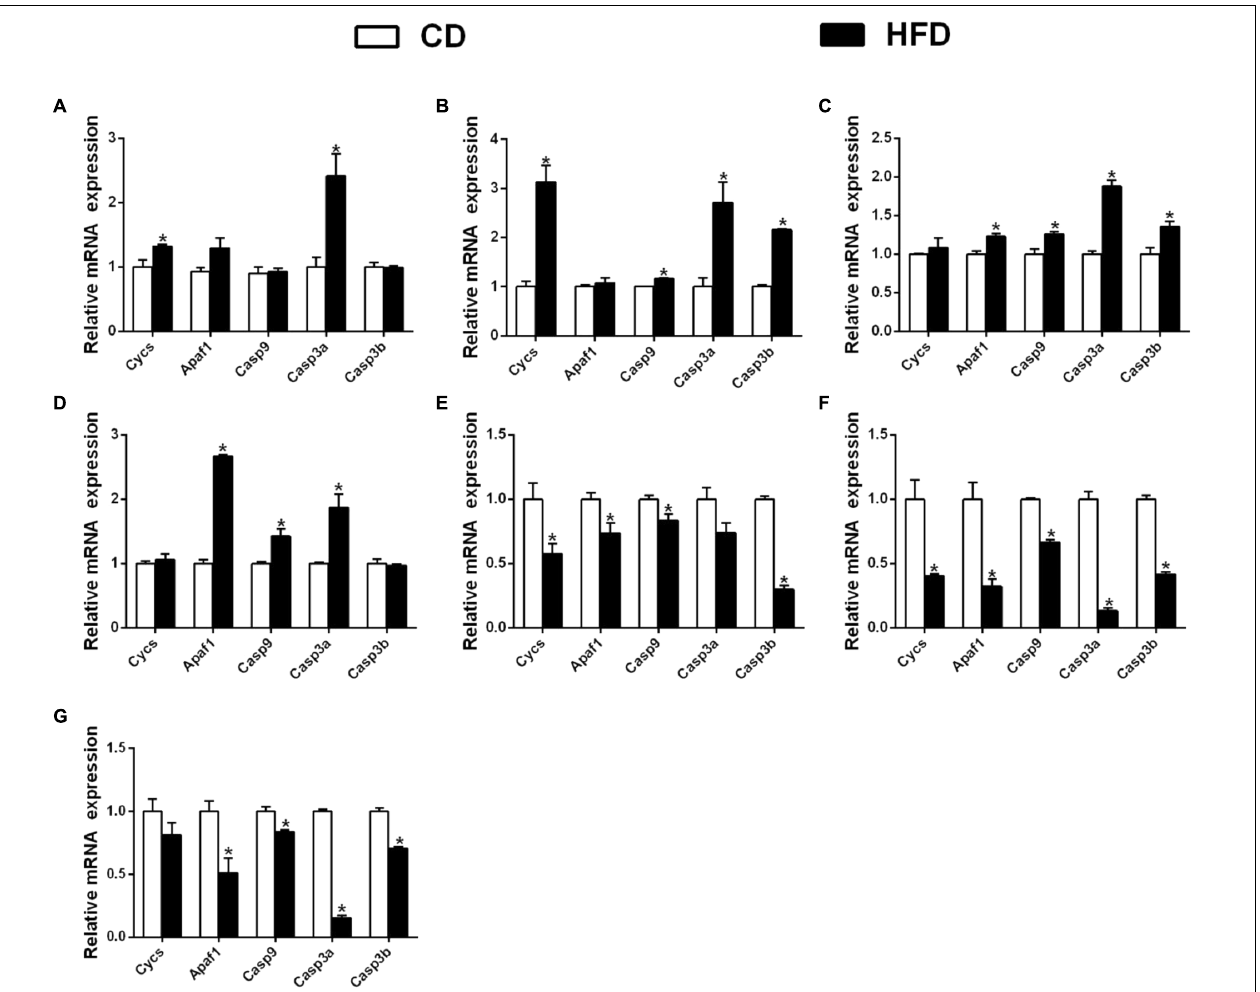
FIGURE 7 | Effect of an HFD on mRNA expression of gene i mitochondria-caspase pathway in P. fulvidraco across different tissues ( A: mesenteric fat; B: intestine; C: ovary; D: kidney; E: heart; F: spleen; G: gill). a , b , c Values are mean ± SEM ( n = three replicate tanks, and three fish were sampled from each tank); Data are expressed relative to the expression of the housekeeping genes ( β -actin and UBCE). Asterisk indicates significant differences between the control and HFD ( t -test, p < 0.05). CD, control diet; HFD, high fat